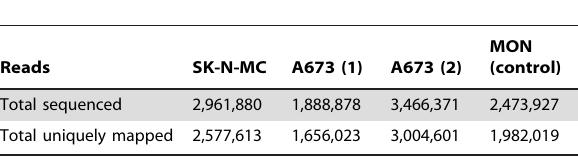
Table 1. Number of reads and corresponding mapped sequences per Chip-Seq